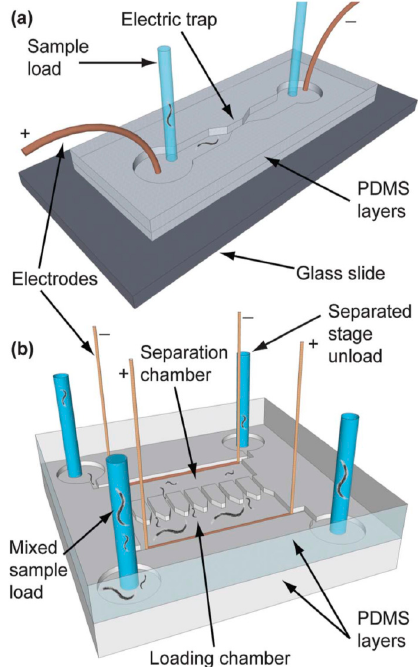
Figure 10. ( a ) The single electrotaxis worm sorter chip developed by Rezai et al. [73] with descriptions of its different parts; ( b ) a continuous electrotaxis worm sorter using the electric trap principle. Reprinted with permission from the Royal Society of Chemistry.